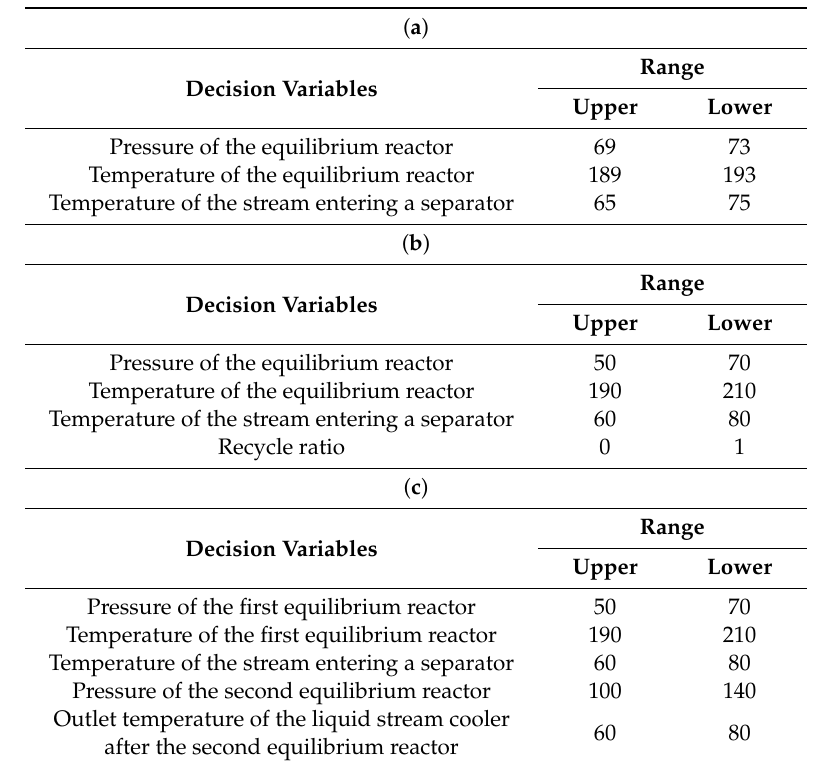
Table 1. ( a ) Range of the decision variables of configuration I; ( b ) range of the decision variables of configuration II; ( c ) range of the decision variables of configuration III.